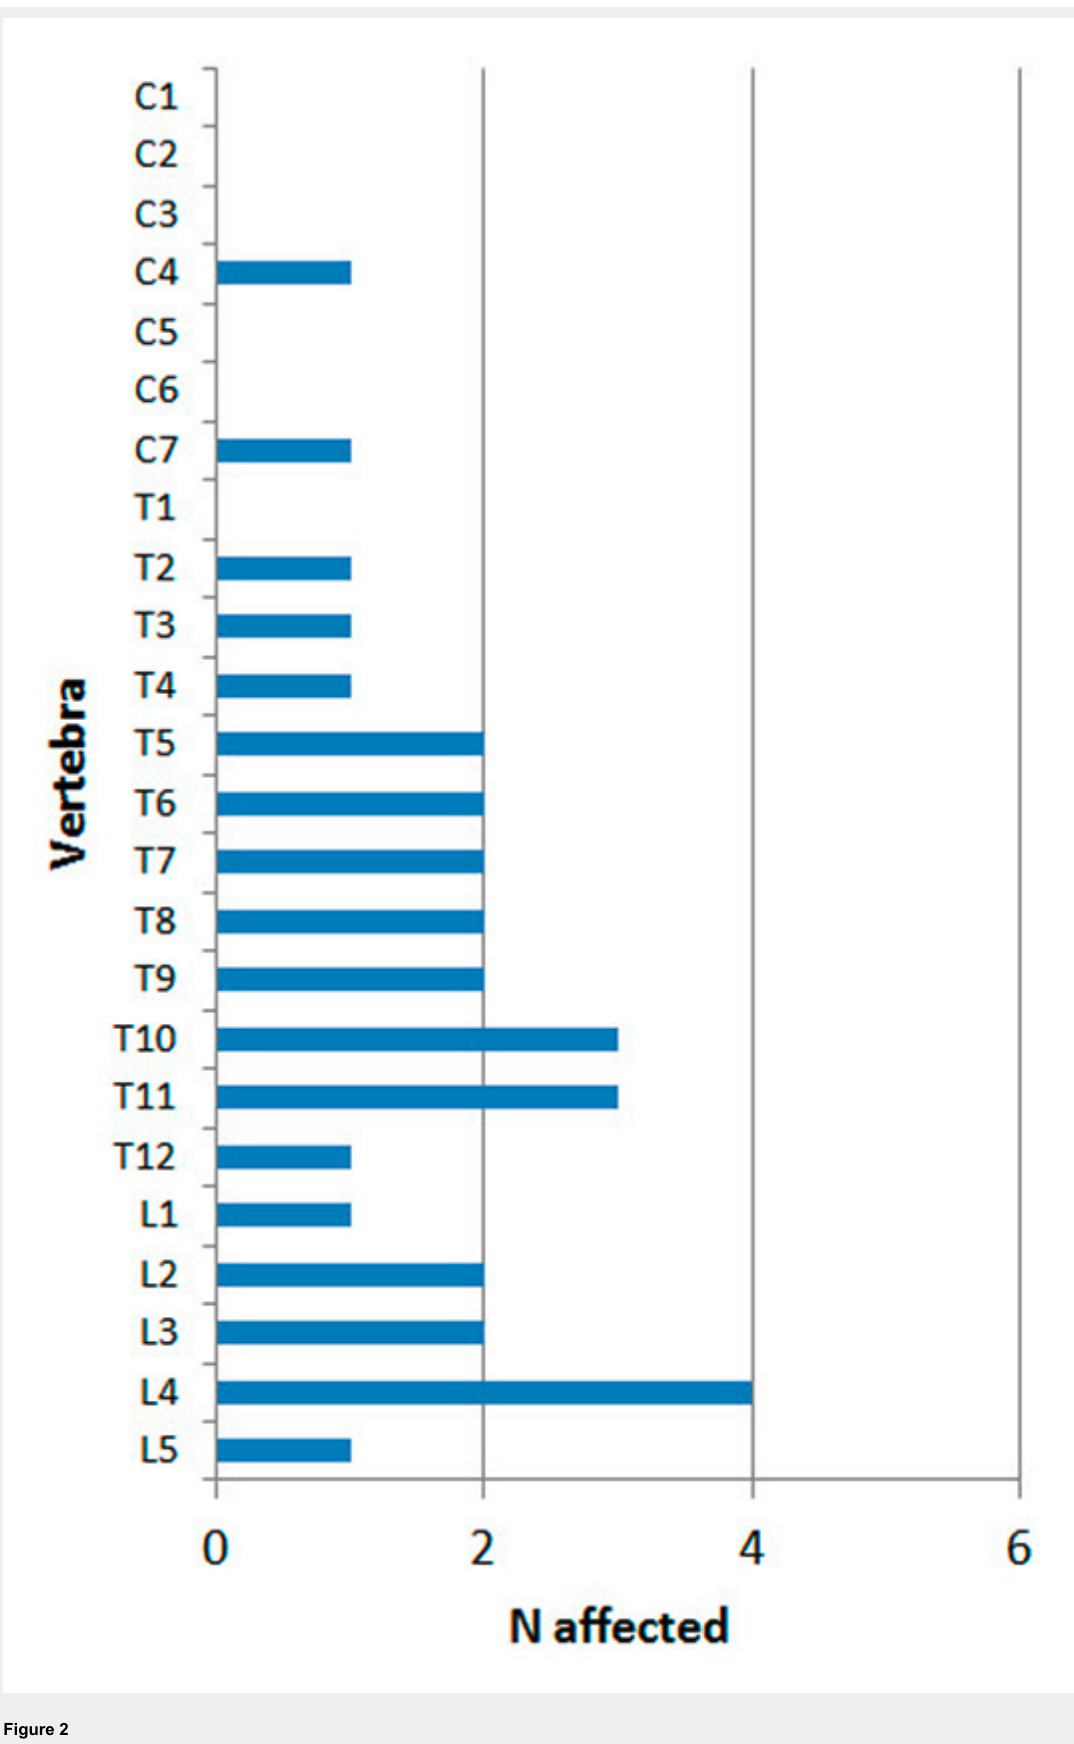
Figure 2 Distribution of lytic lesions throughout the